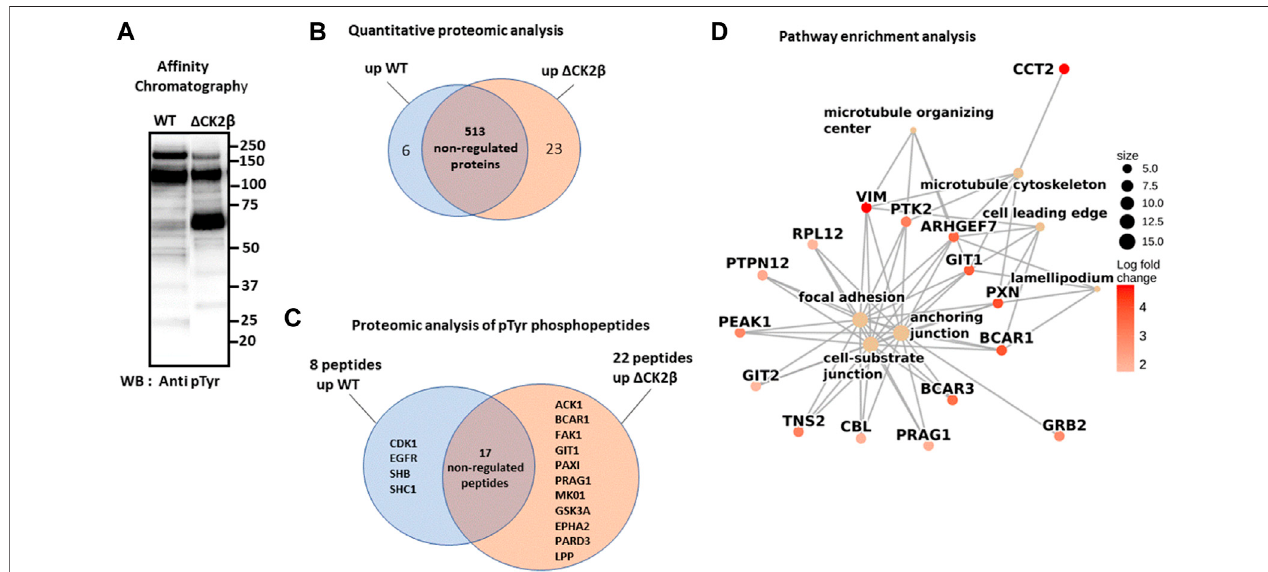
FIGURE 2 | LC-MS/MS and GSEA analysis of differentially elevated levels of Tyr-phosphorylated proteins in WT and Δ CK2 β MCF10A cells. (A) Proteins immunopuri fi ed from WT and Δ CK2 β MCF10A cell lysates were analyzed by Western blotting for pTyr proteins using the 4G10 antibody. (B) Venn diagram showing differentially abundant proteins between WT and CK2 β -depleted cells in samples obtained by immunoaf fi nity puri fi cation of Tyr-phosphorylated proteins ( SupplementaryTableS1 ). (C) VenndiagramshowingtheproteinsinwhichdifferentiallyabundantpTyr-phosphopeptidesbetweenWTandCK2 β -depletedcells wereidenti fi ed( SupplementaryTableS2 ).ThesepTyr-phosphopeptideswereidenti fi edandquanti fi edfromtheLC-MS/MS analysesofpeptidesamplescomingfrom a double enrichment starting from the two cell types: immunoaf fi nity puri fi cation of Tyr-phosphorylated proteins followed by the enrichment of their tryptic peptides on a TiO 2 resin. (D) Signi fi cant gene ontology cellular components enriched from proteomics quanti fi cation of phosphoproteins ( Supplementary Table S3 ) according to corrected p -valuesbytheBenjamini – Hochbergmethod < 0.05.Cellularcomponentnamesaredisplayedasyellownodesandboundtocorephosphoproteinsthatledto a signi fi cant enrichment by GSEA. The core phosphoproteins are the nodes colored in red according to their log2 fold change value.